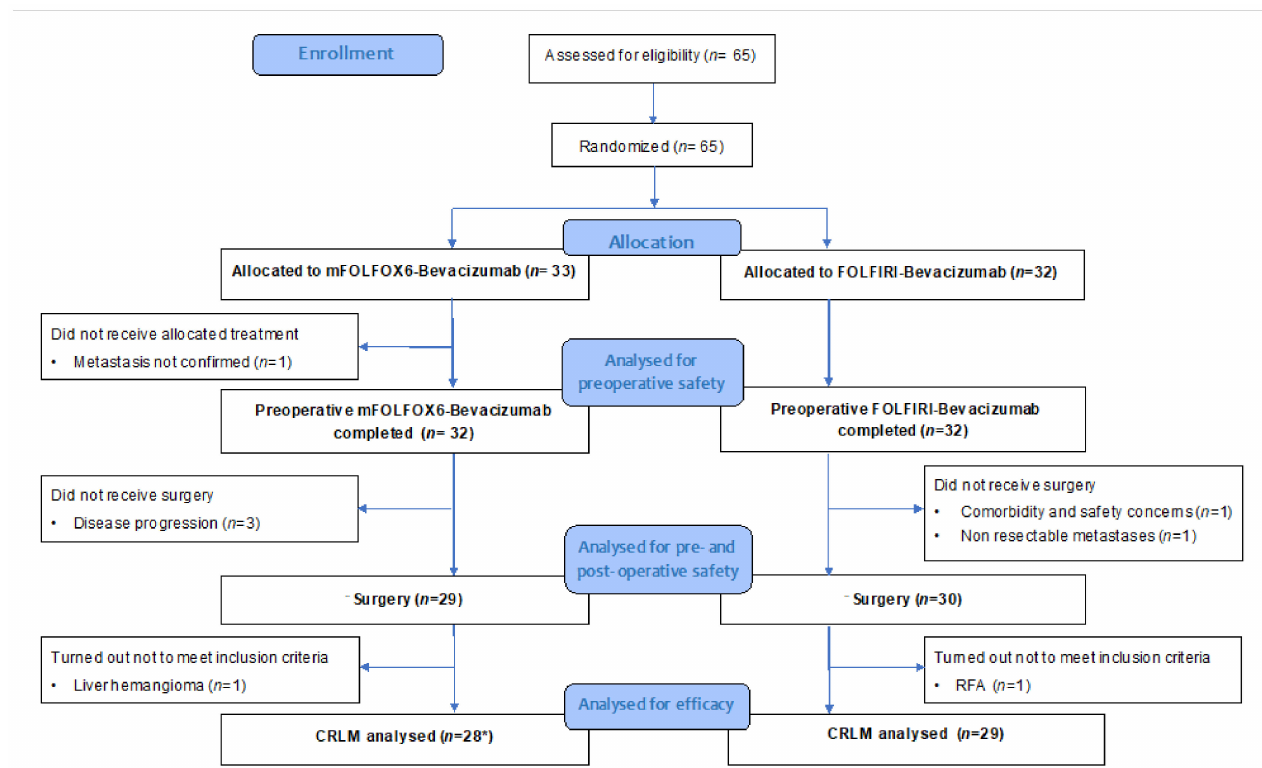
Figure 1. CONSORT flow diagram of the trial. CRLM: colorectal liver metastasis; RFA: radiofrequency ablation. * Including 1 patient with lung